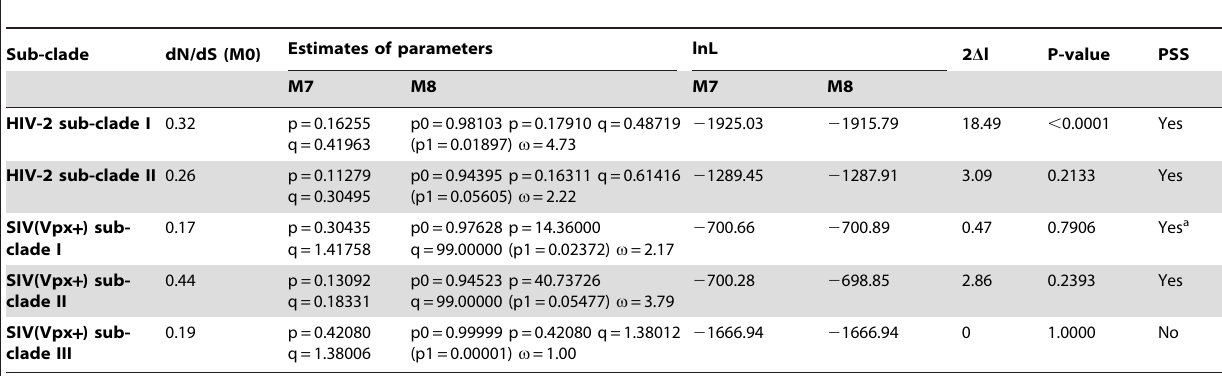
Table 3. Site-model (M7 vs. M8) test for vpx genes from two HIV-2 sub-clades and three different SIV(Vpx + ) sub-clades.